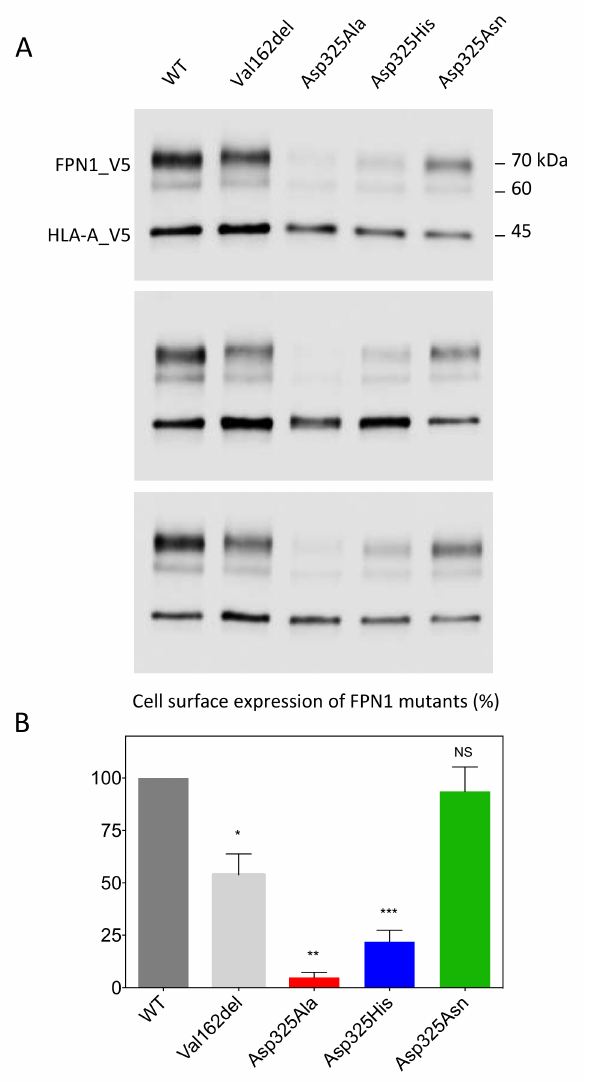
Figure 1. Effects of the Asp325Ala, His, and Asn variants on the cell-surface expression of HsFPN1. ( A ) HEK293T cells were transiently co-transfected with plasmids encoding either a V5-tagged FPN1 protein (WT or variant) or a V5-tagged HLA-A protein. Human leukocyte antigen (HLA)-A was used as a control and as a standard for normalization, being a cell-surface protein with no known role in iron metabolism. At 48 h after transfection, cell-surface proteins were selectively purified and ana- lyzed by Western blotting using a peroxidase-conjugated mouse anti-V5 antibody. ( B ) Densitometric scans of FPN1 levels normalized to HLA-A. The error bars represent the standard deviation of the 3 independent experiments presented in panel A. p values were calculated using Student’s t -test. * p < 0.05, ** p < 0.01, and *** p < 0.001.